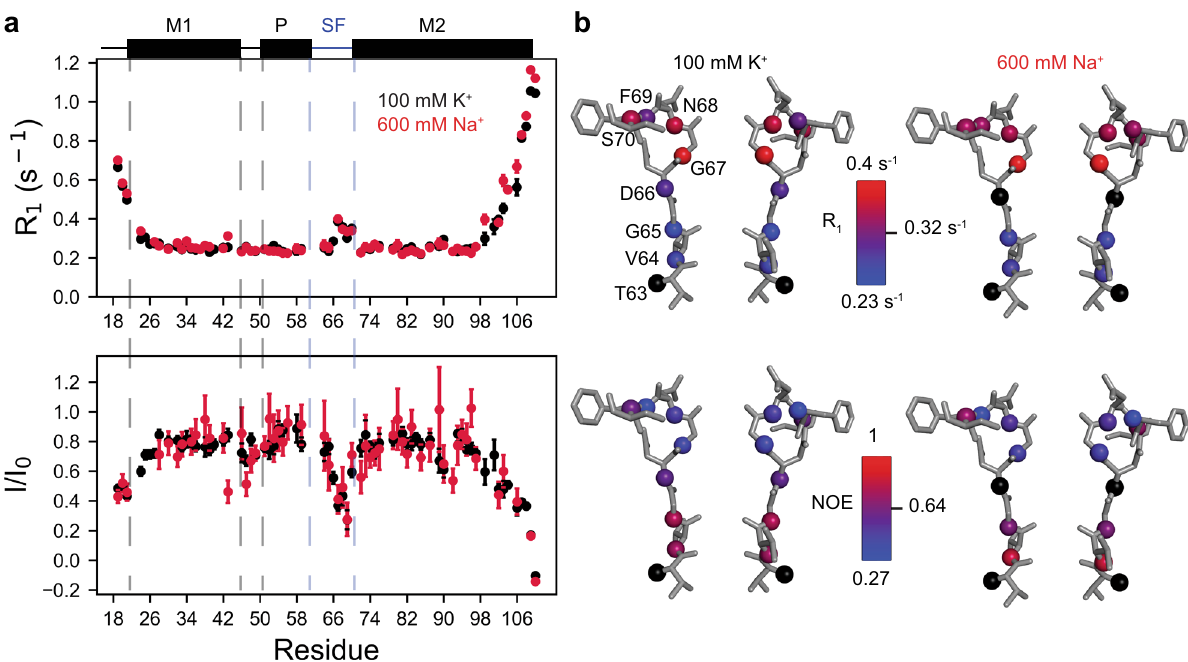
Fig. 2 Gradient in ps-ns dynamics across NaK SF. a Backbone amide 15 N R 1 and { 1 H} – 15 N NOE values recorded at 750 MHz for NaK in 100 mM K + (black) and 600 mM Na + (red). Secondary structure elements are shown above, where helices are rectangles and loops are lines. The boundaries between elements are based on the 3E8H [10.2210/pdb3E8H/pdb] crystal structure. Residues 63 – 70 are indicated by the blue lines and are shown as sticks in ( b ). Error bars were calculated as the SD of 500 Monte Carlo simulations, as described in the Methods. Note that the error in R 1 is smaller than the marker for the majority of residues. b Relaxation data plotted on the NaK SF (showing 2 of 4 opposing subunits). Backbone N atoms are shown as spheres and are colored according to the scale indicated for each parameter. Residues for which data are unavailable due to resonance overlap or lack of assignment are colored